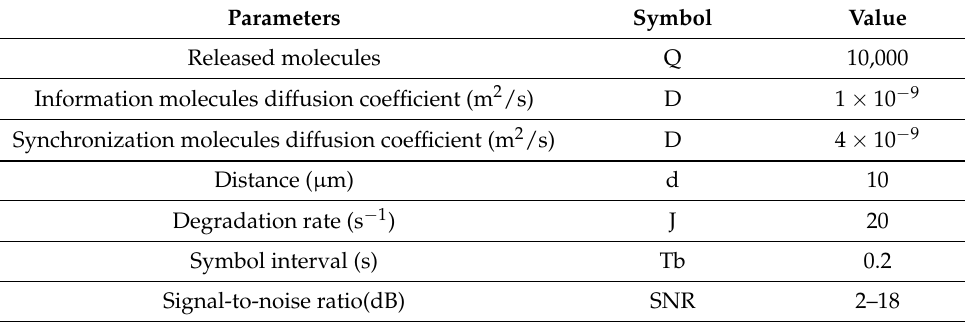
Table 1. System parameters used for simulation. Parameters Symbol Value Released molecules Q